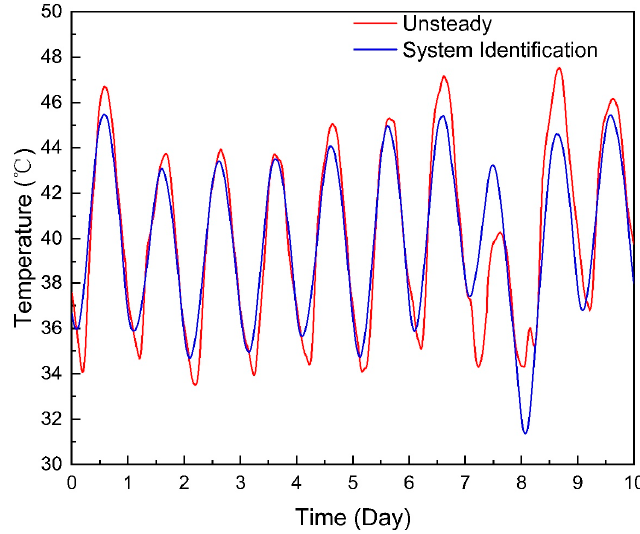
Figure 14. State space identification result.